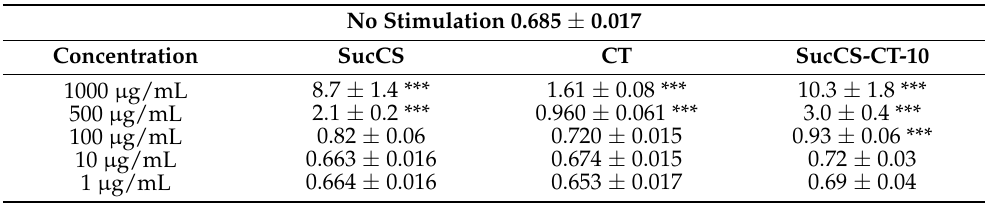
Table 4. CD54 expression by THP-1 cells in response to in vitro stimulation with SucCS-CT-10 conjugate. Data are presented as mean ± SD ( n ≥ 6); the data are shown as CD54 MFI.